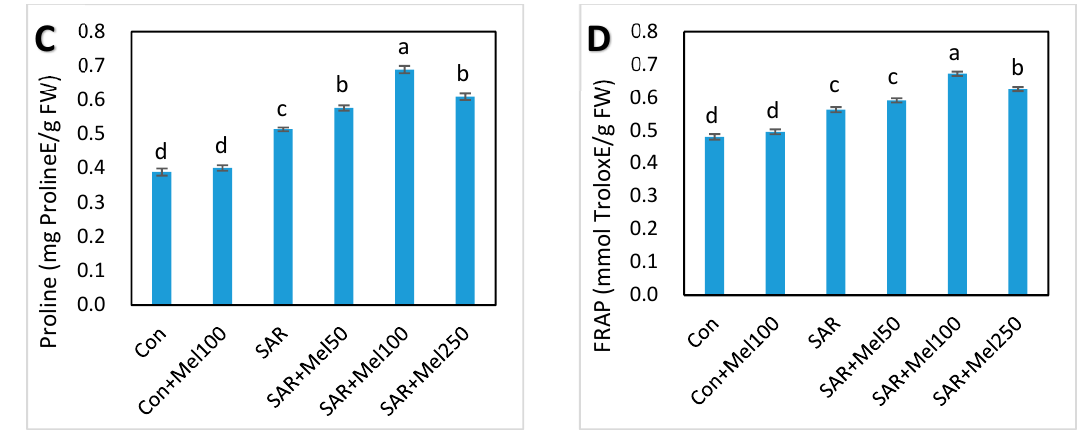
Figure 7. Changes of nonenzymatic and total antioxidant activities in tomato leaves by SAR and/or melatonin treatments. ( A ) phenolics; ( B ) flavonoids; ( C ) proline; ( D ) FRAP (Ferric reducing antioxidant power) values. Data indicates here the mean of four replications. Vertical bars indicate the standard error. Means not sharing a common letter within the graph are significantly different at p ≤ 0.05 according to Tukey’s test.